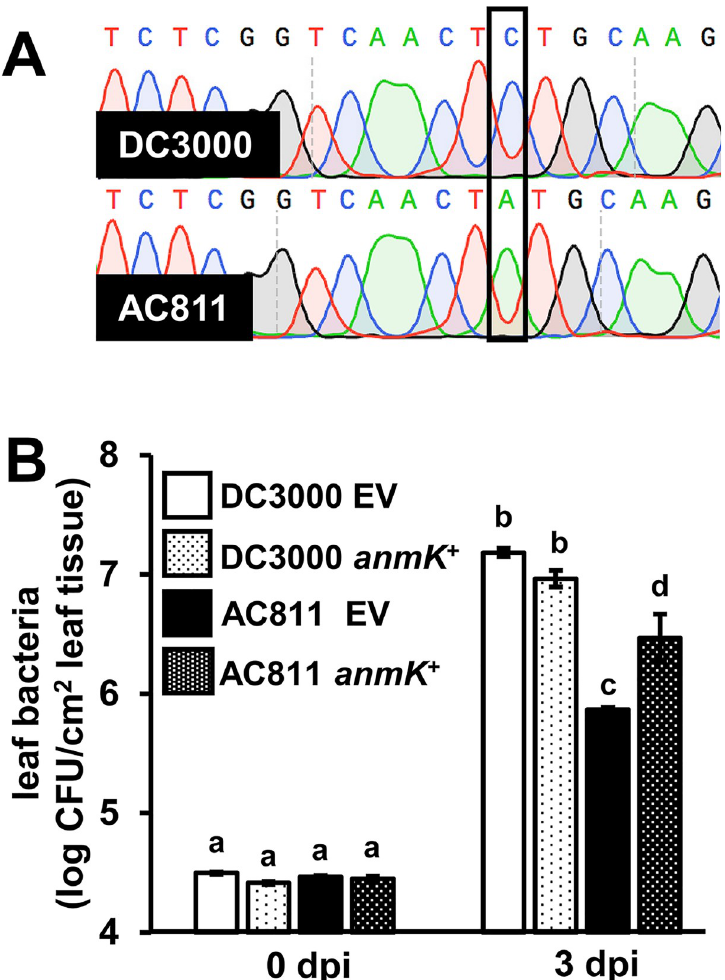
Fig 1. A nonsense mutation in anmK contributes to decreased growth of AC811 in Arabidopsis leaves. (A) Sanger sequencing chromatograms of the PSPTO_0606 locus PCR-amplified from genomic DNA of DC3000 and AC811. (B) Leaves of Col-0 Arabidopsis plants were syringe-infiltrated with DC3000 or AC811 carrying either empty pME6010 (EV) or pME6010:: anmK plasmid. Data shown are means ± SE of leaf bacteria measured by serial dilution plating. Abbreviation dpi is days post-infection. Statistical groups were determined by ANOVA with multiple pairwise t- test comparisons and Tukey’s post-hoc HSD analysis, p < 0.05. Data are representative of three independent experiments.